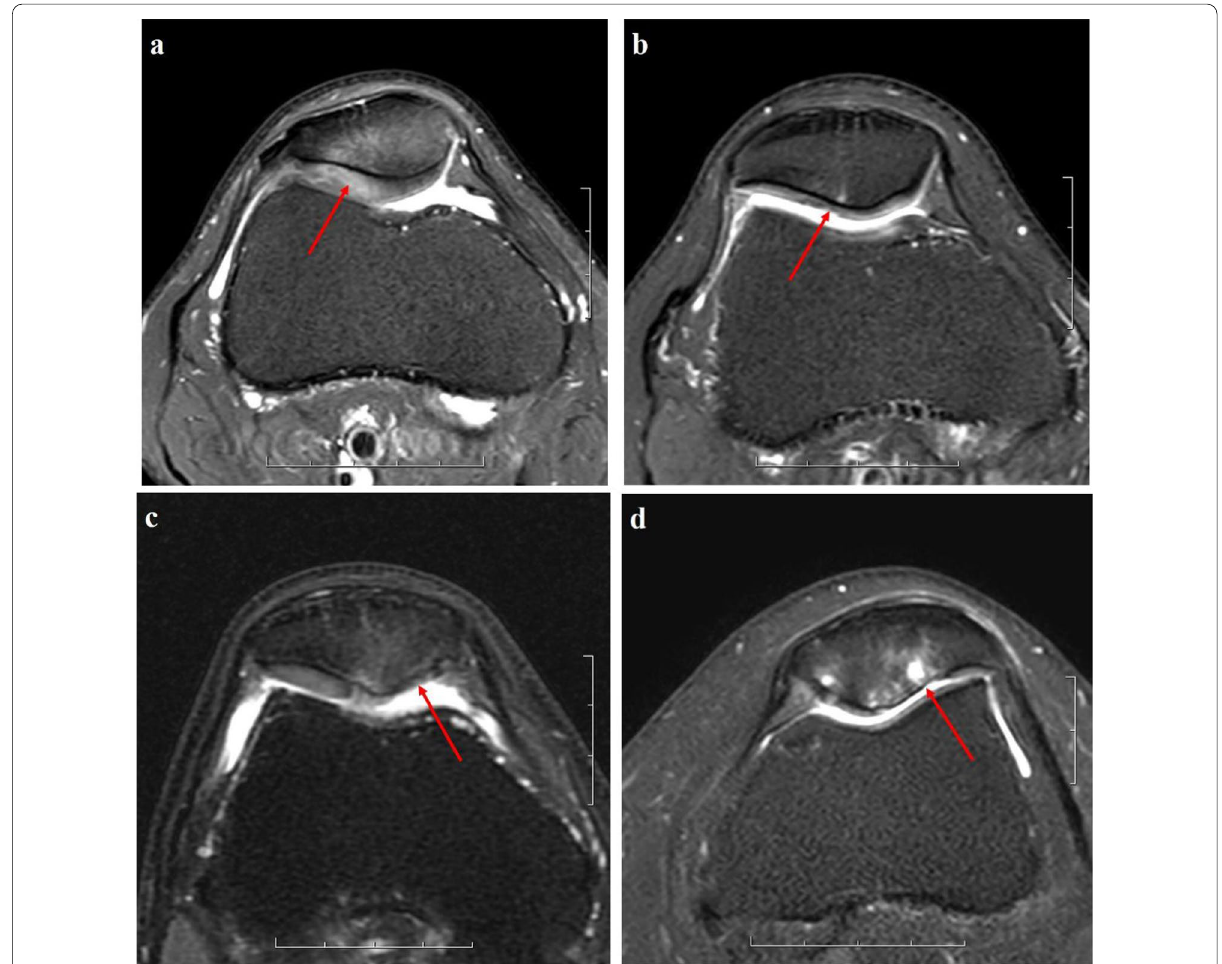
Fig. 2 The modified Noyes classification system of patellar cartilage lesions. a Grade 1—increased T2 signal intensity of morphologically normal cartilage; b grade 2A—superficial partial-thickness cartilage defect less than 50% of total articular surface thickness; c grade 2B—deep partial-thickness cartilage defect greater than 50% of the total articular surface thickness; d grade 3—full-thickness cartilage